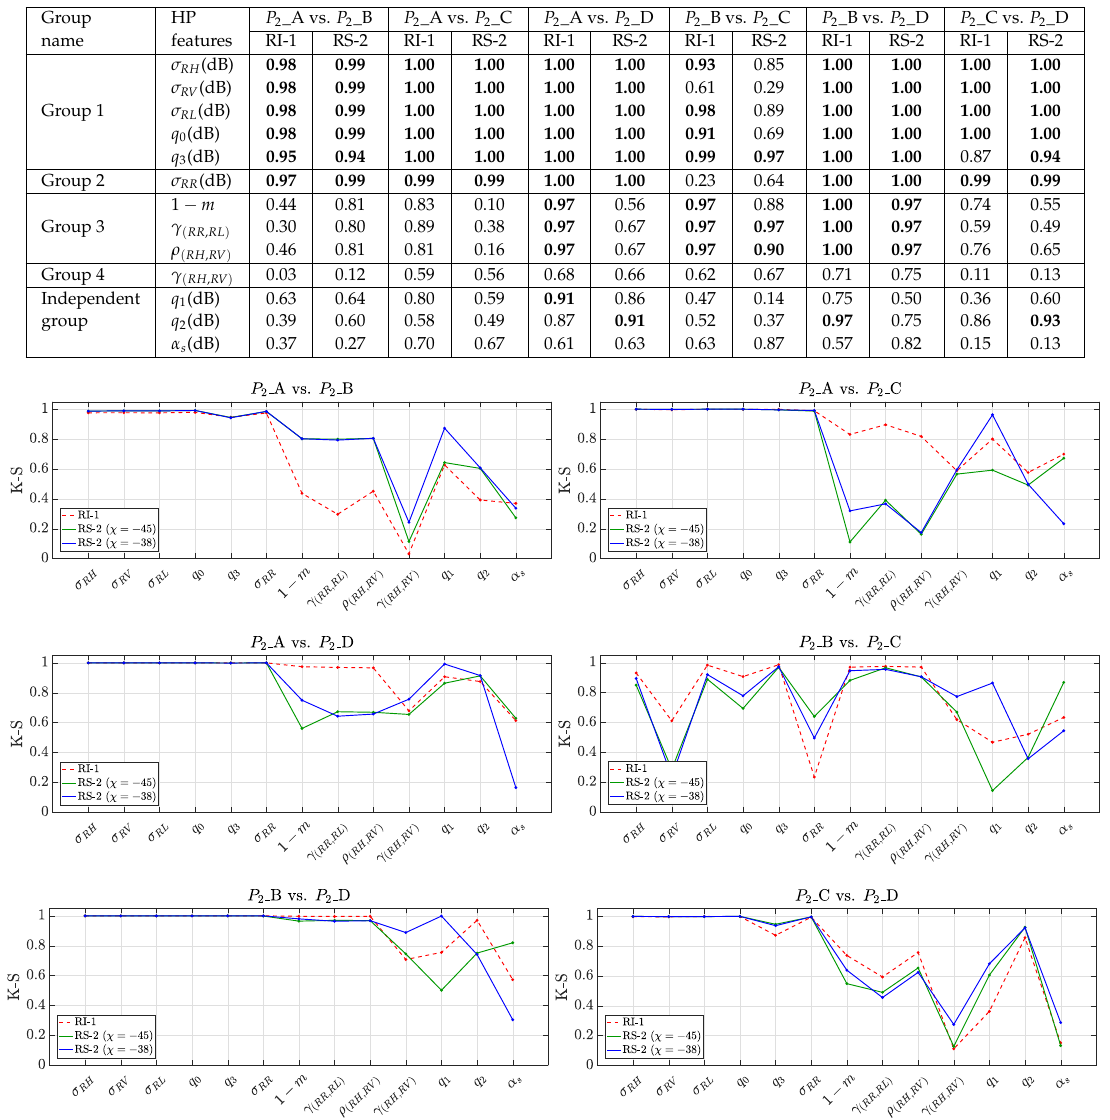
Figure 8. Top panel; a table containing the K-S values between all combinations of paired sea ice types in P 2 . The first column shows groups as described in Table 3. The values greater than 0.9 are in bold. Bottom panels; the corresponding values are shown in the plots, where the y-axis shows the K-S values calculated for each of the paired sea ice types (i.e., ROIs) (red for the RI-1 features and green (blue) for the RS-2 features with an ellipticity angle of χ = − 45 ◦ ( − 38 ◦ )), while the x-axis shows the corresponding features. Note that only the K-S values for RI-1 features and the RS-2 features using an ellipticity angle of χ = − 45 ◦ is shown in the